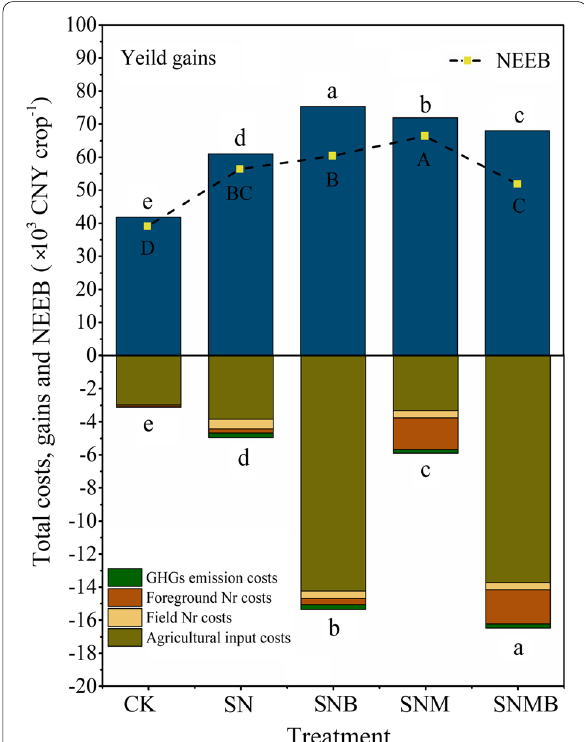
Fig. 6 Vegetable yield gains, NEEB, total costs incurred by GHG emissions, Nr releases, and inputs under different treatments in intensive vegetable production. The lowercase letters represent significant differences in total costs, gains and uppercase letters represent NEEB (p < 0.05)